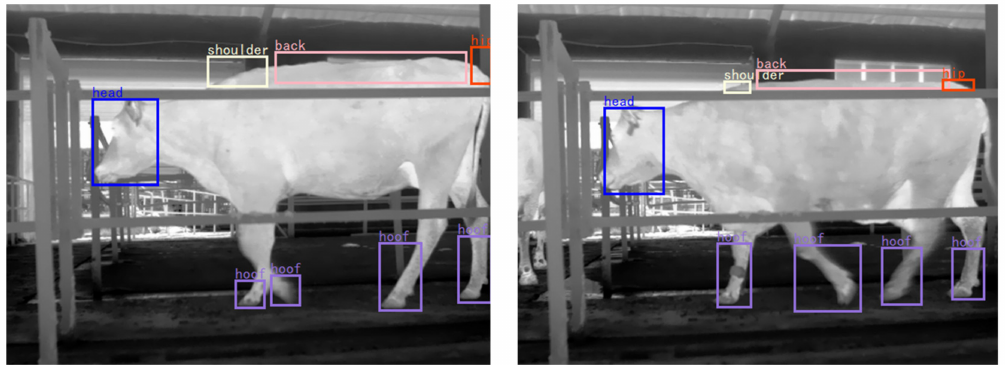
Figure 2. Examples of the feature extraction of cows using a deep learning